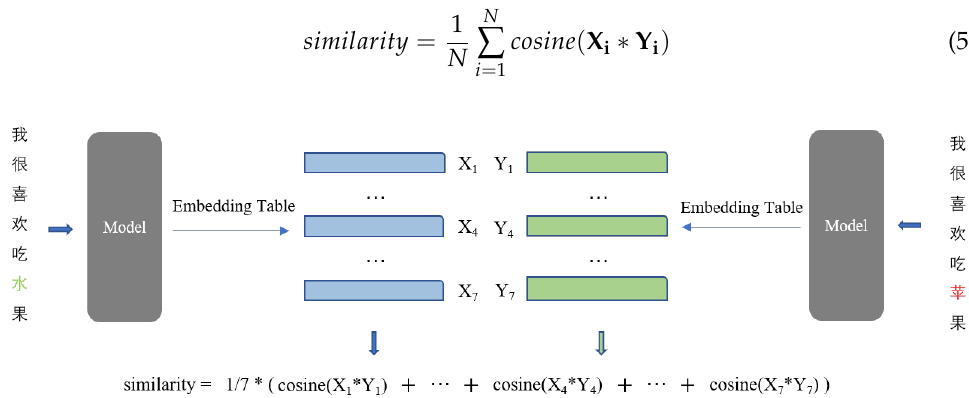
Figure 5. Our method calculates the semantic similarity (similarity) when the model changes 水 to 苹 . This process need the cosine function and model’s embedding